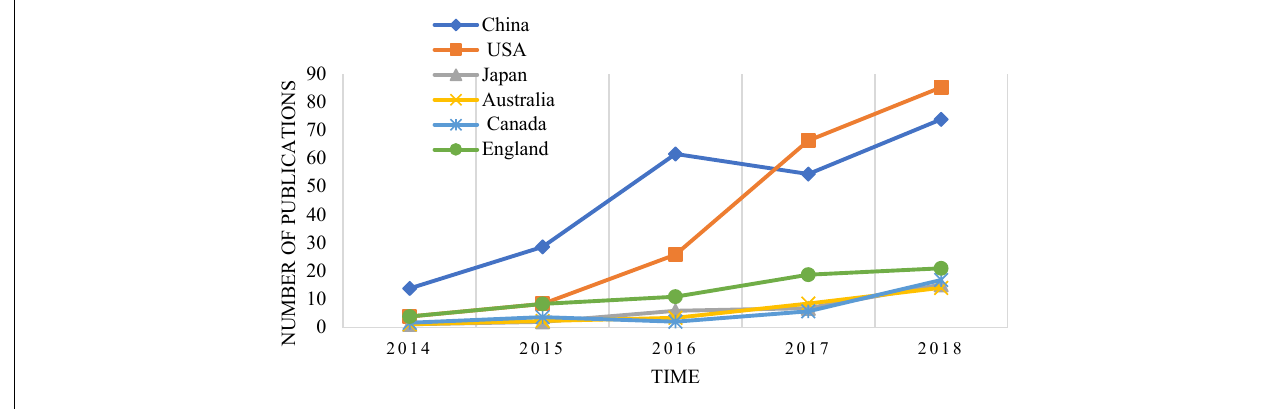
FIGURE 7 | The trend of the combination of artificial intelligence and law in various countries over time.